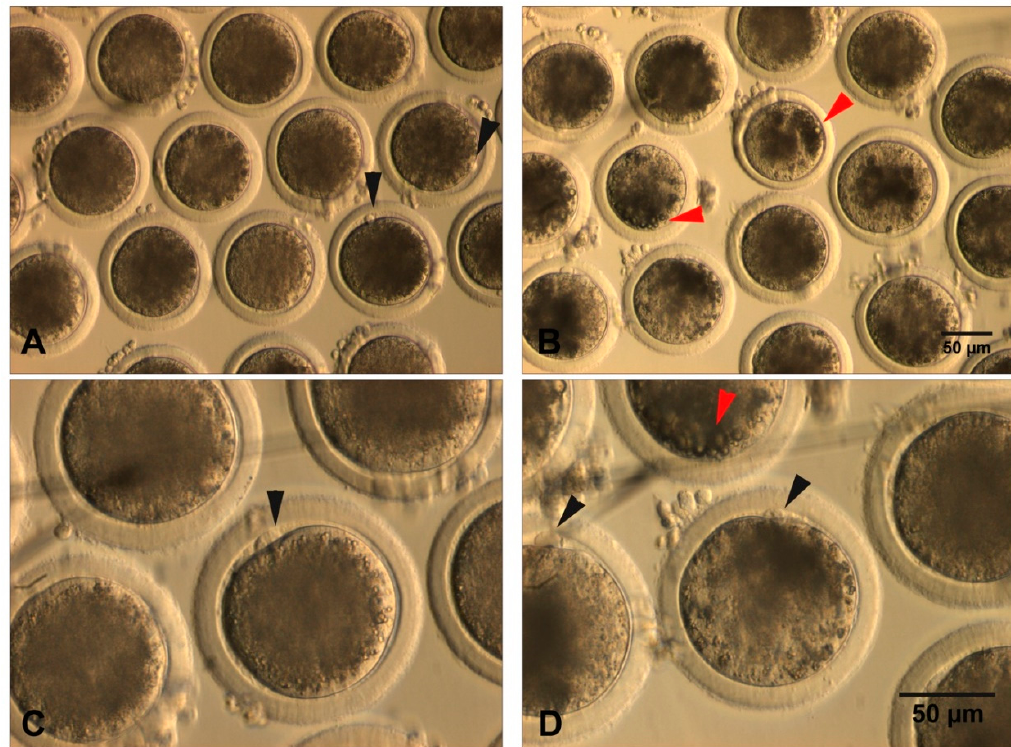
Figure 2. Denuded MII bovine oocytes after 24 h of IVM. ( A , C ) oocytes showing a homogeneous dark cytoplasm. Black arrows depict the first polar body; ( B , D ) oocytes showing a heterogeneous pale and punctuated cytoplasm. Black arrows indicate the first polar body, while red arrows depict dark areas of intense lipid accumulation (cytoplasmic granulations).